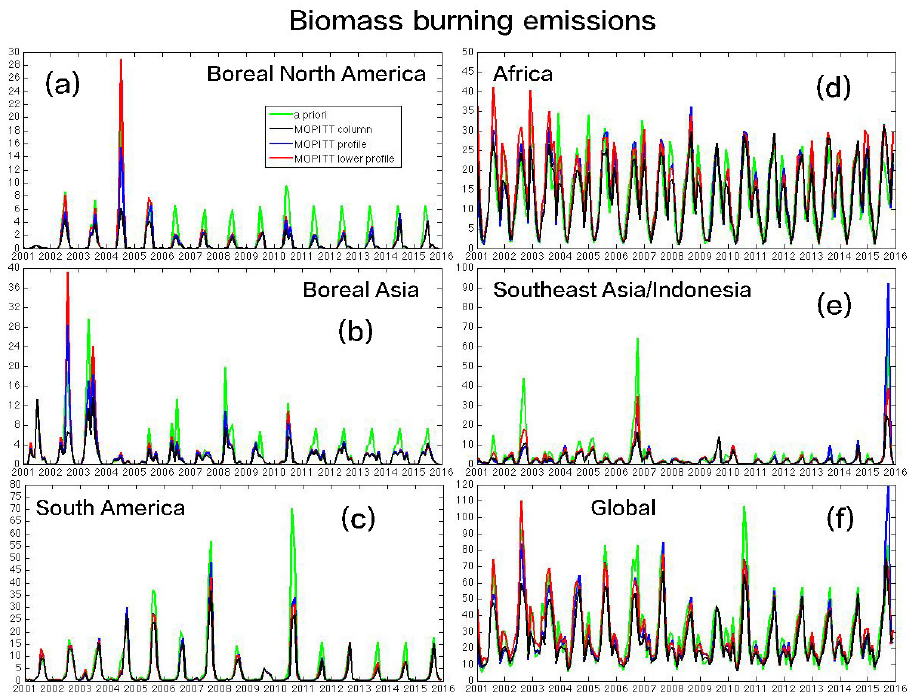
Figure 8. Monthly biomass burning CO emissions (with unit Tgmonth − 1 ) for 2001–2015: a priori emission (green) and a posteriori emis- sions constrained with MOPITT column data (black), MOPITT profile data (blue) and MOPITT lower-tropospheric profile data (red). The region definition is shown in Fig.